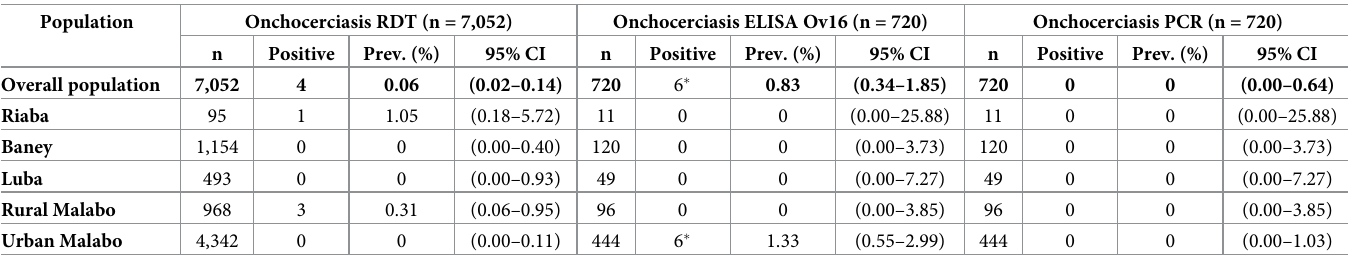
Table 2. Prevalence of onchocerciasis in children less than 10 years old tested by Ov-16 IgG4 RDT, ELISA and PCR, Bioko Island, September 2016 to January 2017.